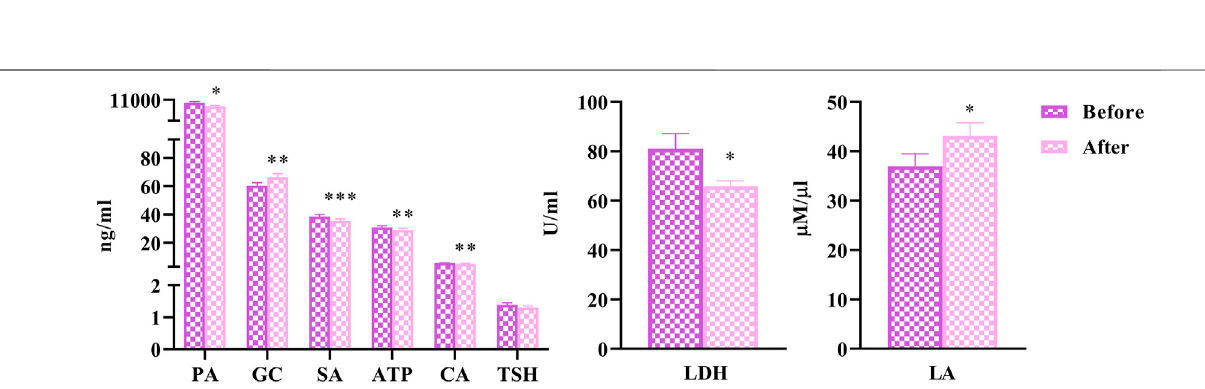
FIGURE 1 | The changes of in fl ammatory factors before and after HLJDD intervention (Before) Oral disease group (After) HLJDD intervention group (* p < 0.05, ** p < 0.01).